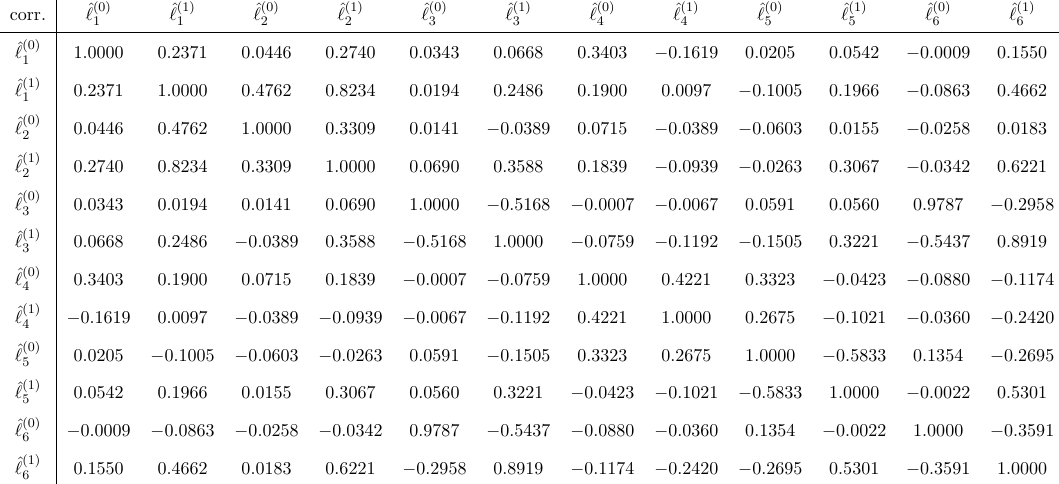
o n o n ^ ‘ ( n ) ^ ‘ ( n ) { in SM (3 = 2 = 1). 1{6 1{6